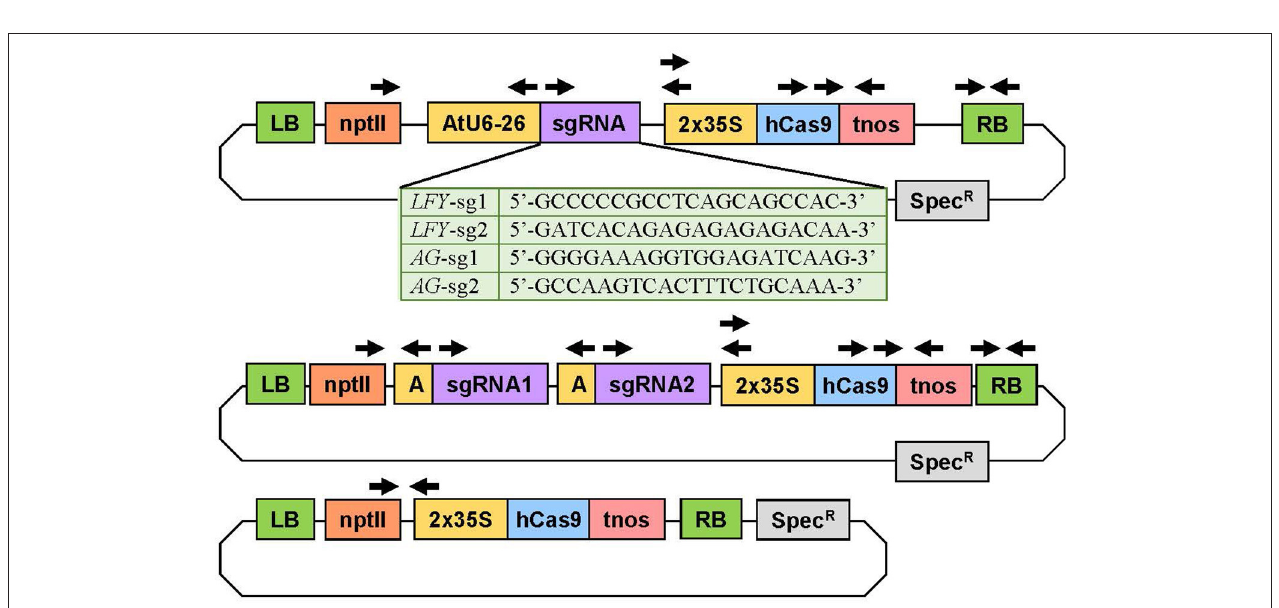
FIGURE 2 | Experimental constructs targeting one or two loci simultaneously. The construct at the top was used to target a single site in the target gene(s). The table below shows the specific sequence of each sgRNA. The plasmid in the middle was used to target two loci in the same gene(s). The plasmid on bottom was the Cas9 control plasmid with no sgRNA. The arrows indicate the primers used to verify the genetic sequence of the plasmids and to determine if the independent insertion events were transgenic. 2X35S, double Cauliflower mosaic virus (CaMV) 35S gene promoter; AtU6-26 or A, Arabidopsis thaliana U6-26 gene promoter; hCas9, human codon-optimized Cas9 gene sequence from Streptococcus pyogenes ; LB, left T-DNA border; nptII, neomycin phosphotransferase II gene sequence for kanamycin resistance; RB, right T-DNA border; sgRNA, gene-specific sgRNA sequence; Spec, spectinomycin resistance gene sequence; tnos, termination region of the nopalene synthetase gene from Agrobacterium tumefaciens